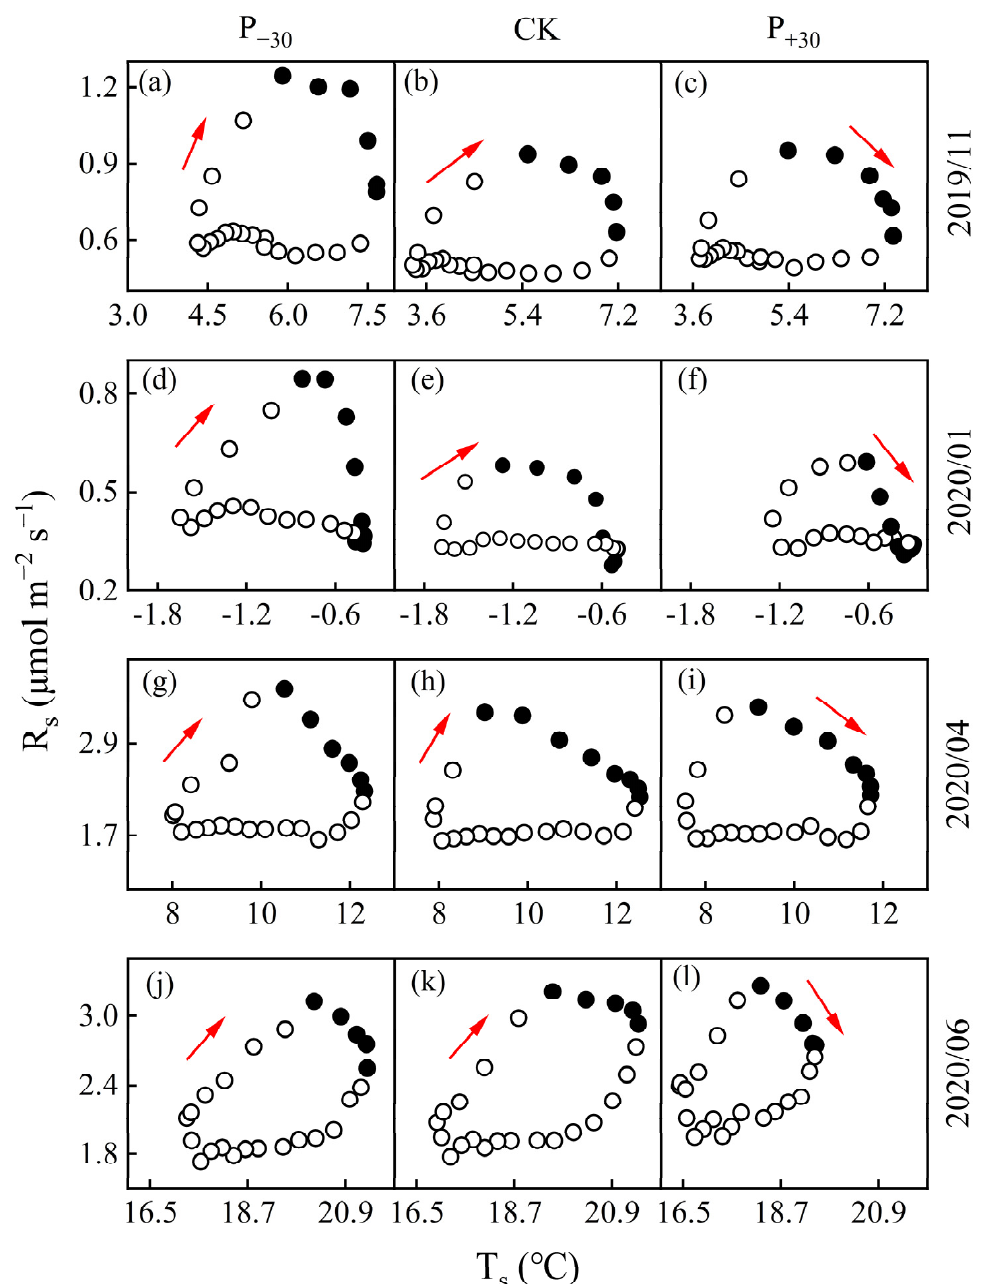
Figure 5. Mean monthly diel cycles of soil respiration (R s ) and soil temperature (T s ) at a depth of 10 cm in November 2019 ( a – c ) and January ( d – f ), April ( g – i ), and June ( j – l ) 2020. The number of solid points and the arrow indicate the monthly average diurnal dynamic lag time between R s and T s and the direction of the diel cycle, respectively.